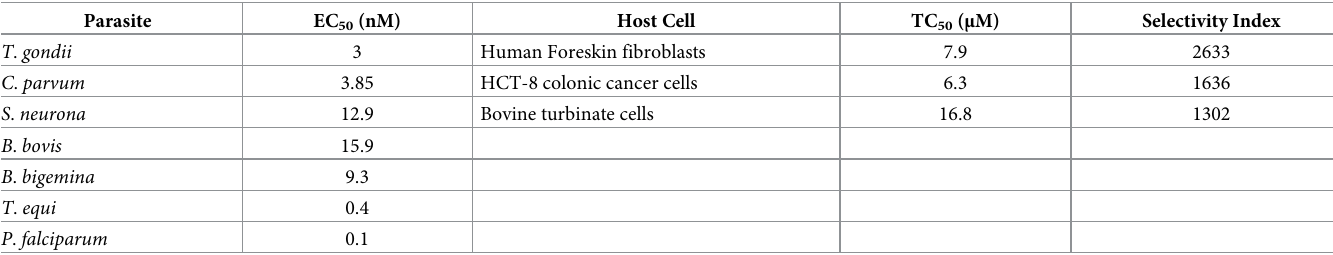
Table 1. EC 50 s, TC 50 s and selectivity indices for parasites and their host cells.